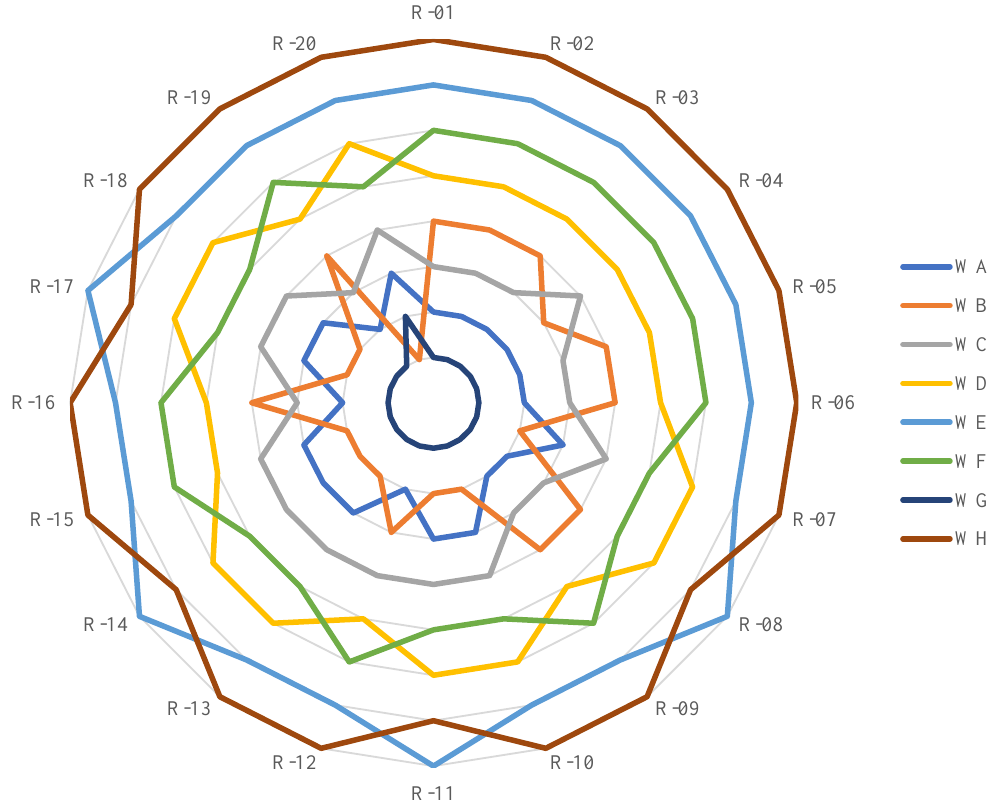
Figure 3. Variation in the rank of different categories of professional drivers during sensitivity anal- ysis.